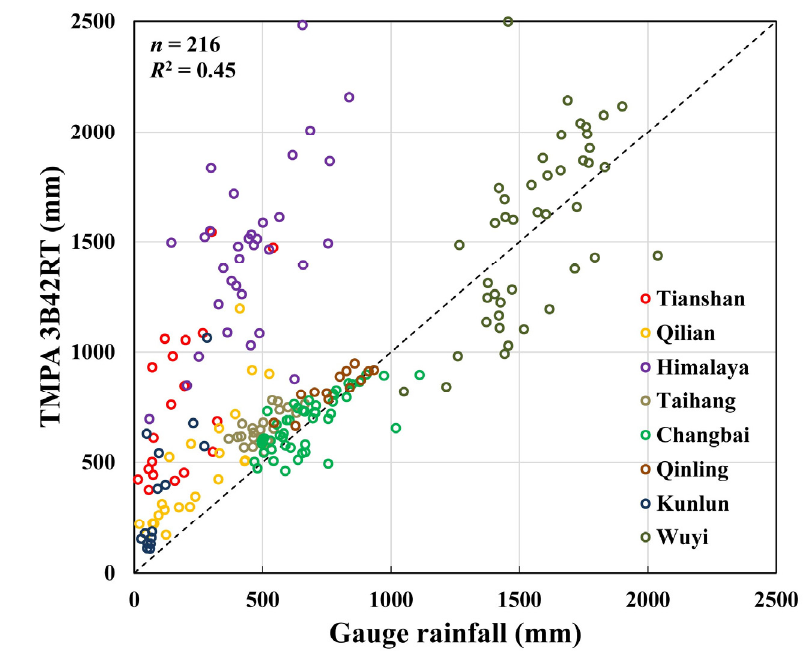
Figure 8. Validation of the mean annual rainfall (2001–2012) from gauge measurements and original